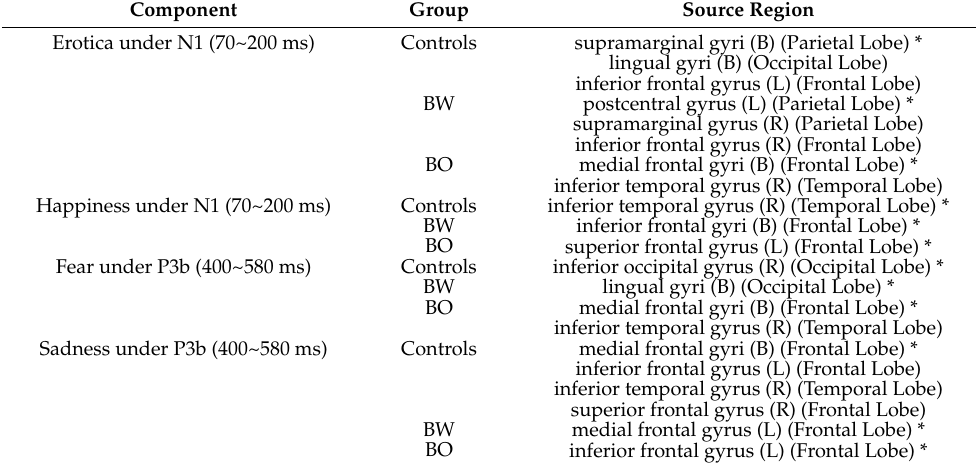
Table 3. Putative N1 and P3b generators in the N1 and P3b time windows in healthy volunteers (Controls, n = 54), bipolar I disorder patients with (BW, n = 27) and without (BO, n = 26)